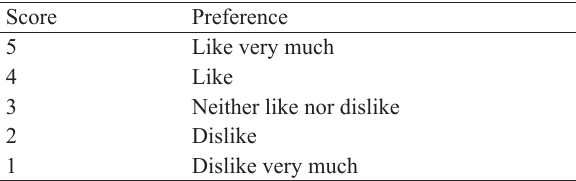
Table 2 Assessment of preference according to hedonic scale Score